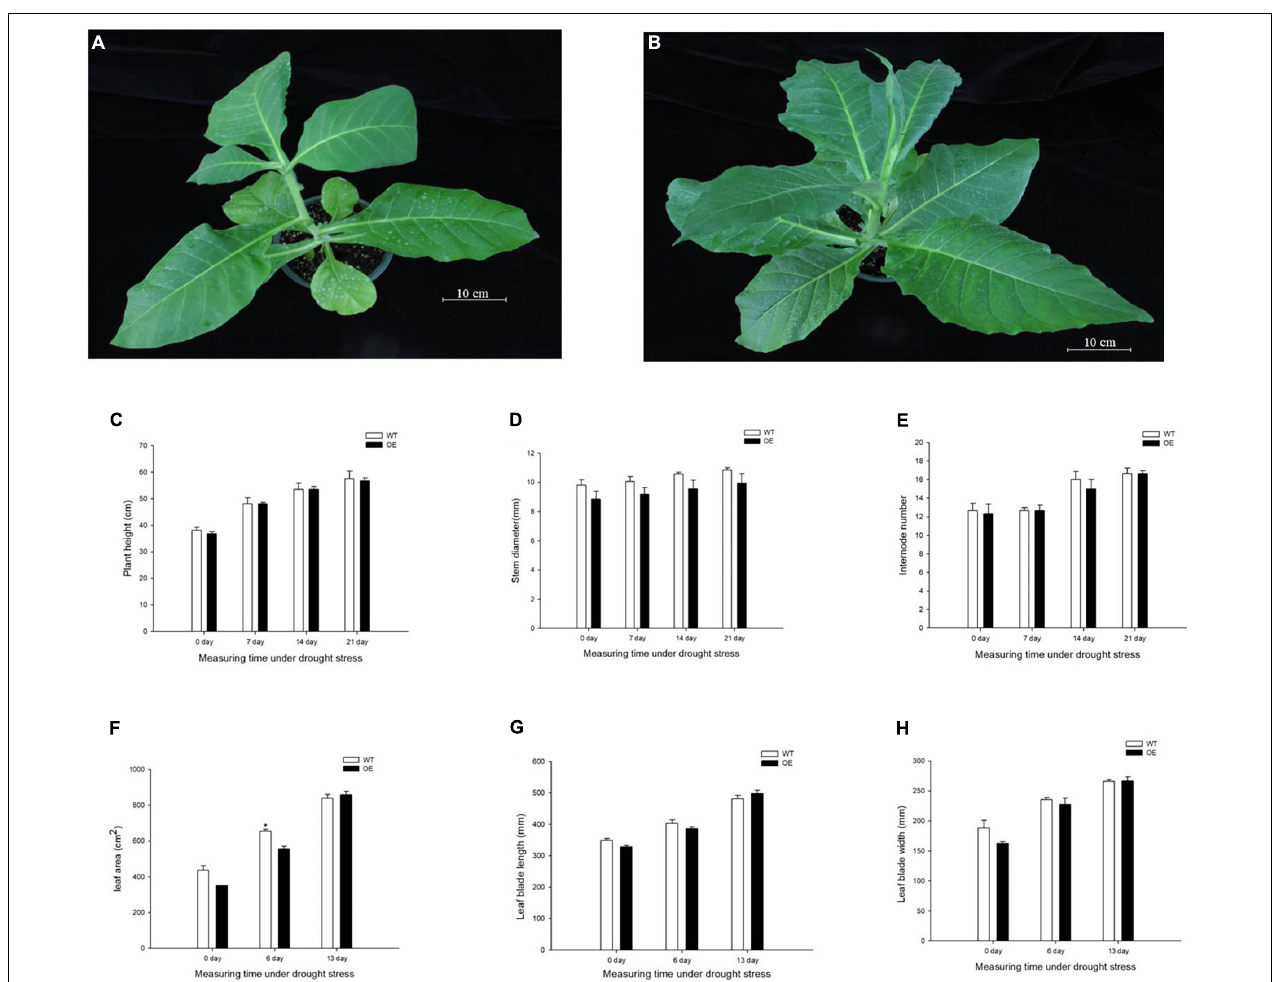
FIGURE 2 | PpCCoAOMT did not affect plant height, stem diameter, or the number of internodes, although it decreased leaf growth in transgenic tobacco plants under transient drought. (A) Phenotype of the WT line after recovery treatment. (B) Phenotype of the PpCCoAOMT -overexpressing (OE) line after recovery treatment. (C) Plant height, (D) stem diameter, (E) internode number, (F) leaf area, (G) leaf length, and (H) leaf width of the WT and OE lines under drought stress. Data are means ( ± SDs) of three replicates. Significant differences between WT and OE lines were determined using independent samples t- tests. * P < 0.05, ** P <